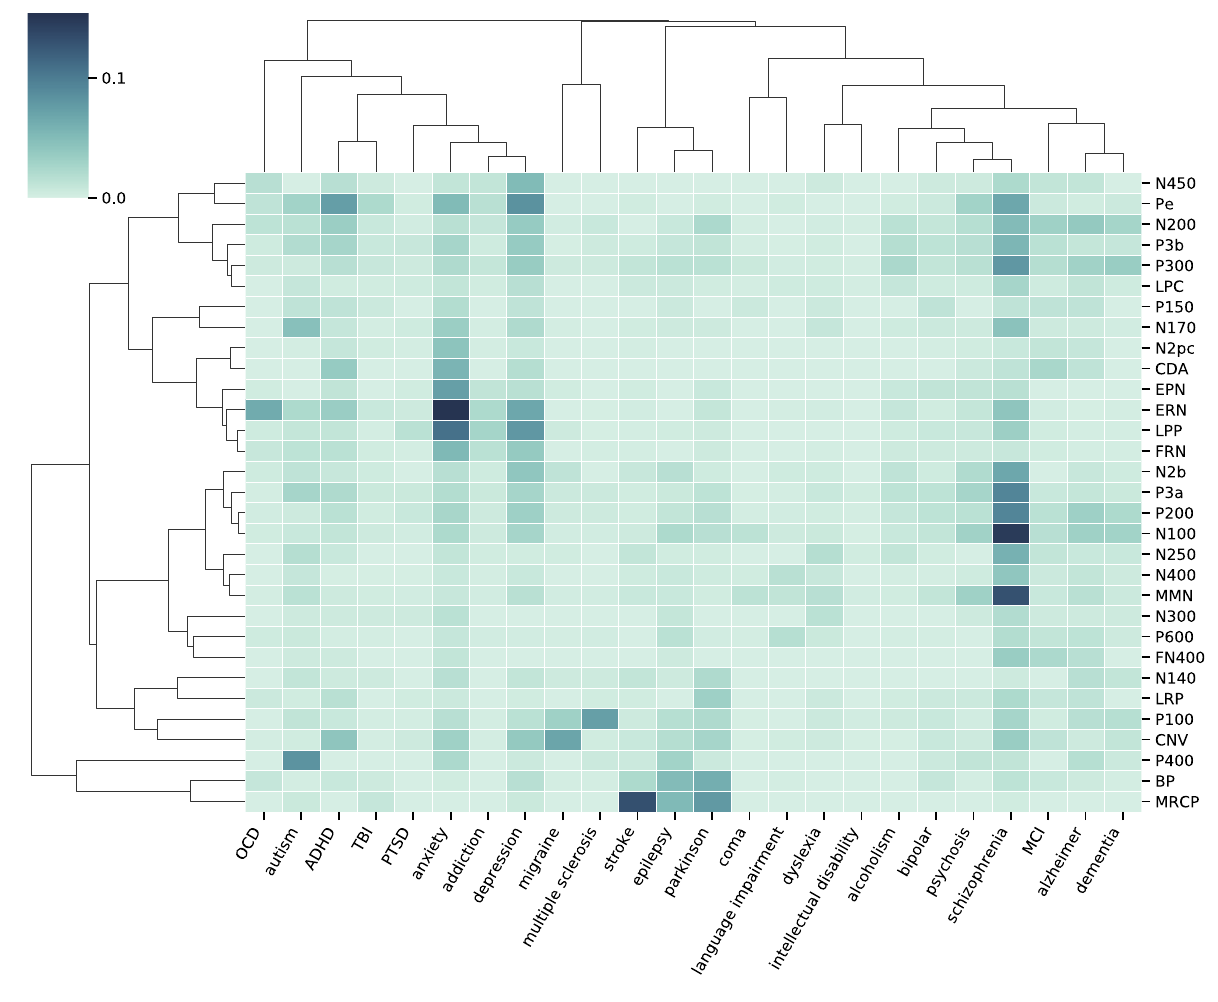
Rows and columns have been re-ordered based on the similarity between ERPs and disorder terms respectively. Dendrograms are hierarchical clustering based on cosine similarity. Note that only ERP components with